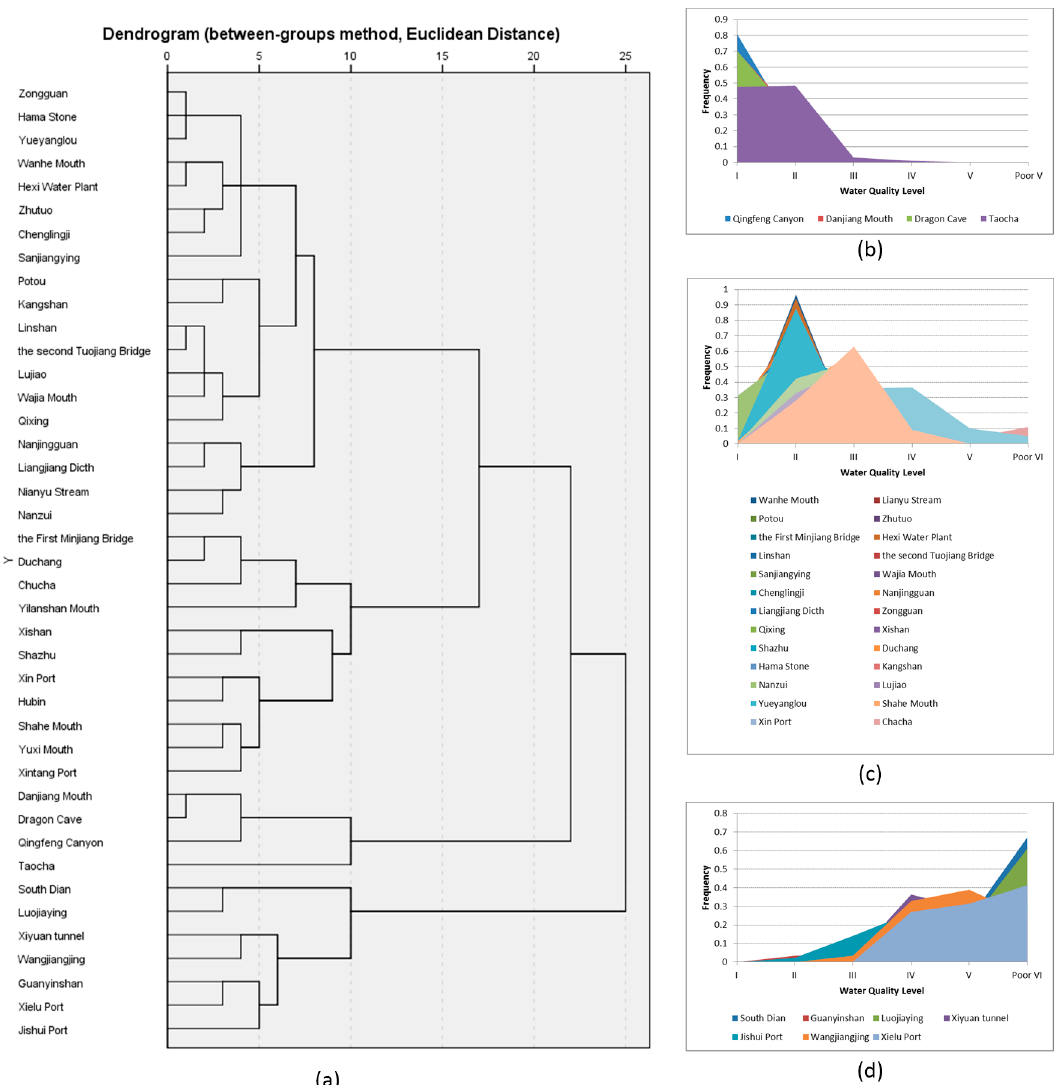
Figure 4. The result of hierarchical cluster analysis on spatial pattern of water quality in the Yangtze River. ( a ) Dendrogram for the WQL frequency of water quality monitoring sections in the Yangtze River. ( b ) Cluster viewer for the water quality level of monitoring section belongs to Group 1. ( c ) Cluster viewer for the water quality level of monitoring section belongs to Group 2. ( d ) Cluster viewer for the water quality level of monitoring section belongs to Group 3.